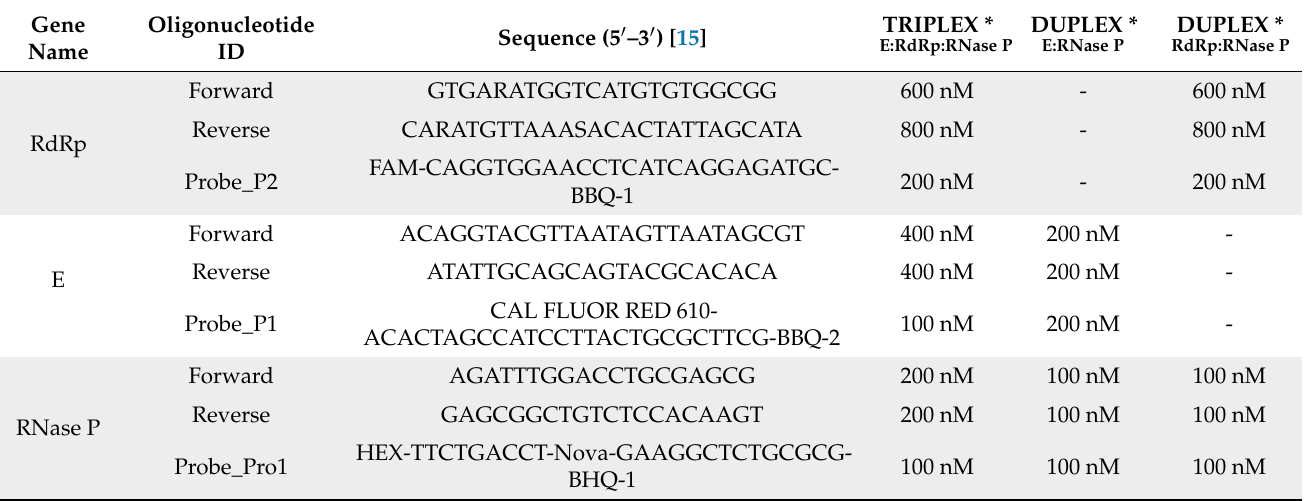
Table 1. List of primers and probes for E, RdRp, and RNase P genes.